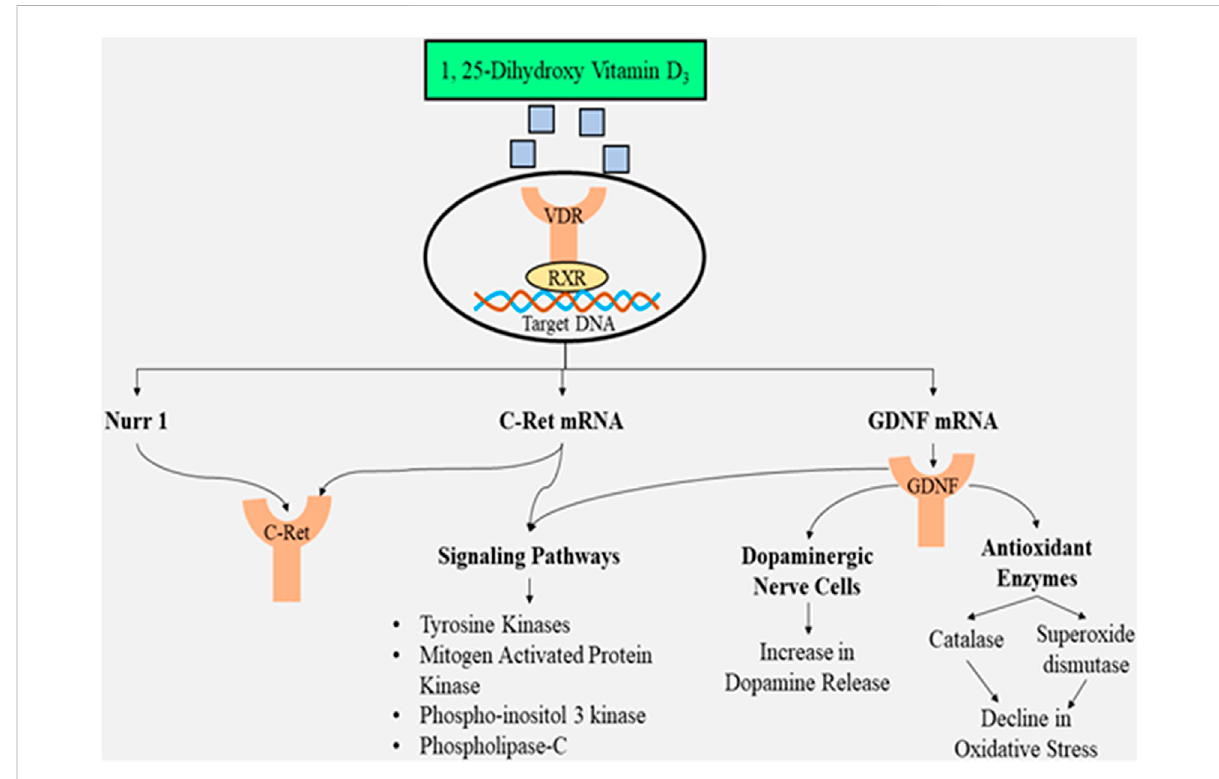
FIGURE 3 Illustration of 1,25-dihydroxy vitamin D3 as a neuroprotective agent preventing dopaminergic neuronal loss and suppressing oxidative stress along with triggering multiple signaling pathways.